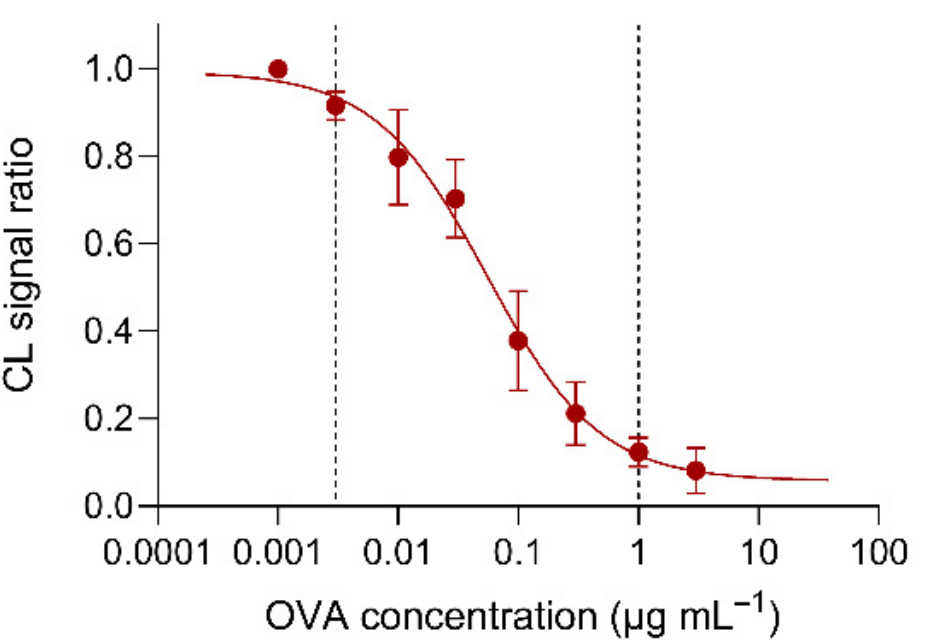
Figure 6. Calibration curve generated by combining the results obtained by analyzing OVA standard solutions with different biosensors. A four-parameter logistic equation was used to fit the experimental data and the equation of the resulting calibration curve was Y = 0.925/(1 + 10(0.932(1.257 + X))) + 0.057 (R2 = 0.994), where Y and X were the CL signal ratio and the logarithm of concentration of OVA standard solutions. The dashed lines show the assay range (see text). Each of the data are the mean ± SD of three measurements.